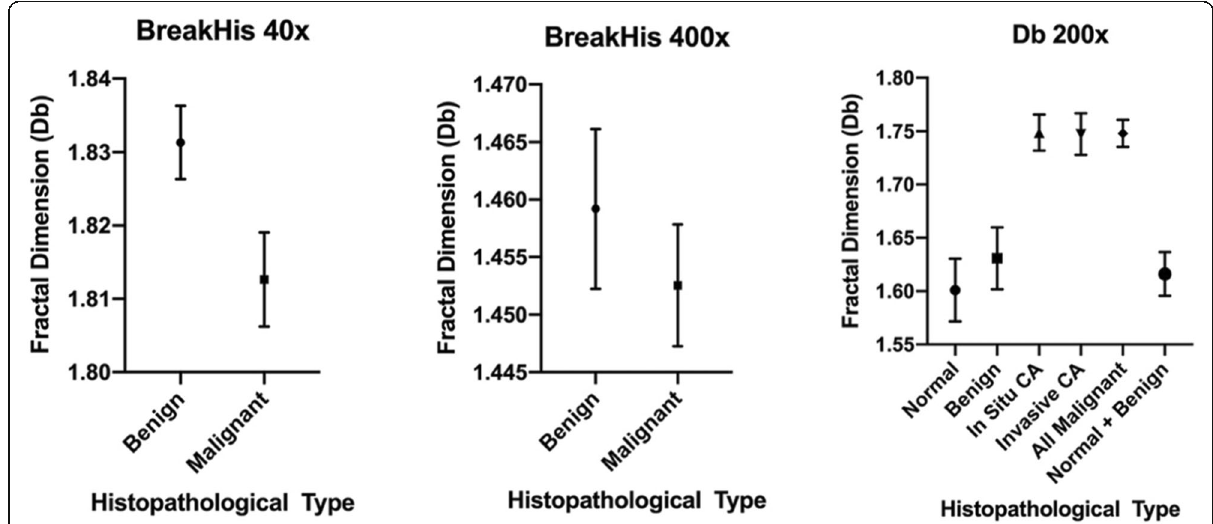
Fig. 5 a One-Way ANOVA analysis results reported as mean with 95% confidence interval of the benign and malignant images from BreakHis under 40x magnification; b One-Way ANOVA analysis results reported as mean with 95% confidence interval of the benign and malignant images from BreakHis under 400x magnification; c One-Way ANOVA analysis results reported as mean with 95% confidence interval of all